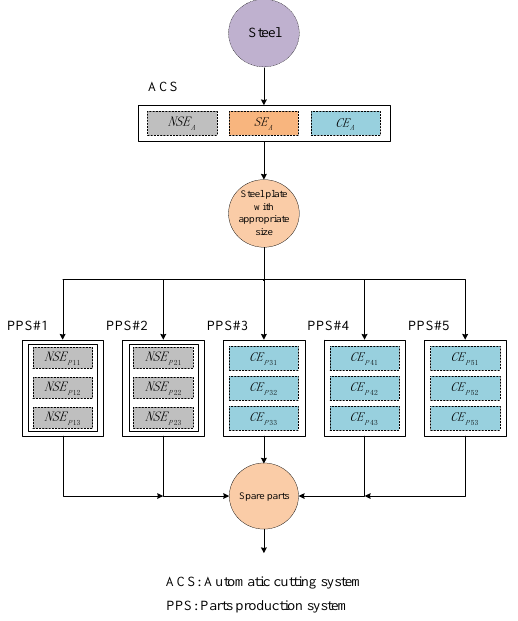
Figure 3. STN model for DR in the stamping process. Non-schedulable tasks (NSTs) include PPS#1 and 2. Schedulable tasks (STs) include ACS and PPS#3, 4 and 5. Each task is composed of three pieces of industrial equipment with corresponding types.